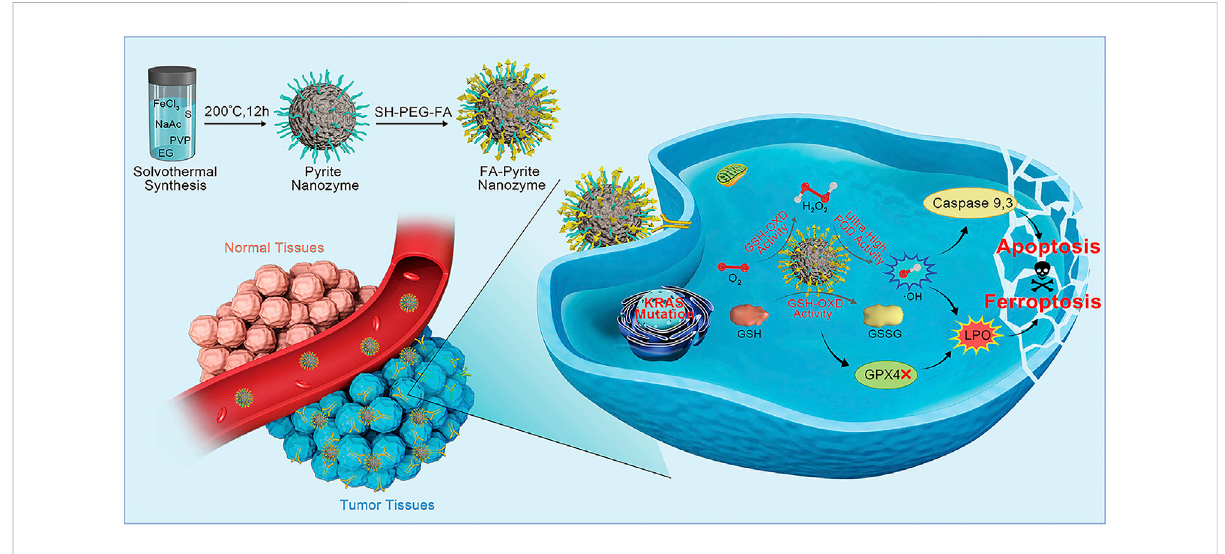
FIGURE 4 Schematic illustration of apoptosis − ferroptosis synergistic tumor therapy by using pyrite nanozymes with ultrahigh POD-like catalytic activity and intrinsic GSH-OXD mimicking ability. Reproduced with permission from Ref. (Meng et al., 2021). Copyright © 2021 American Chemical